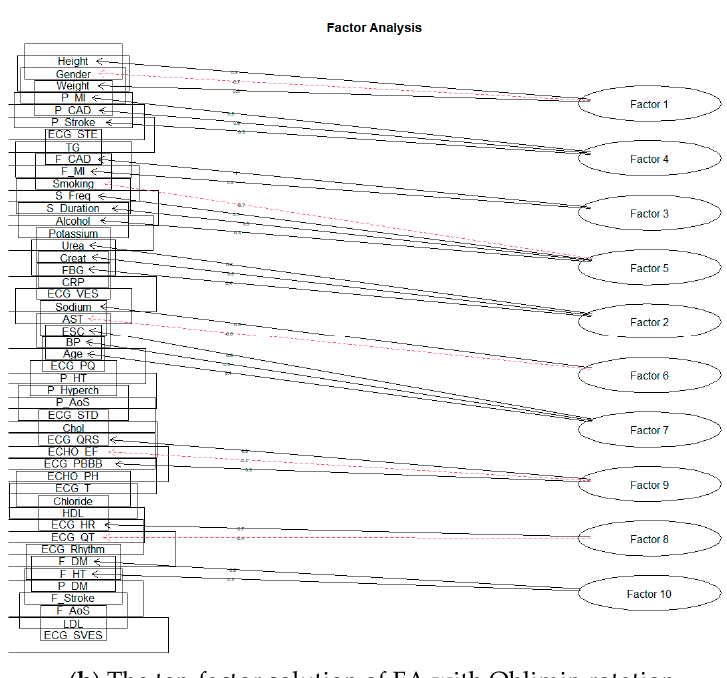
Figure 9. The solution of FA for Oblimin rotation.